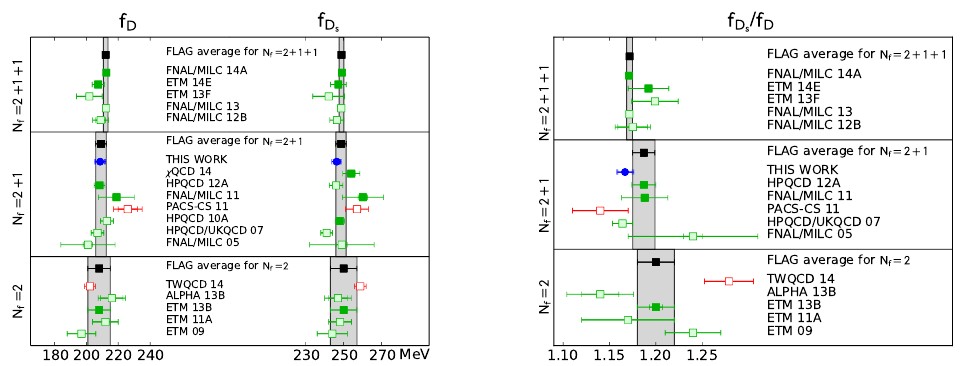
Figure 14 . Superposition of our results (blue circles) to the data presented in the most recent FLAG report [21]. The colour scheme of the remaining data points follows the FLAG convention, presented in detail in section 2 of ref [21]. The small error bar shows the statistic error only, whilst the large error band includes both, the statistic and the systematic error.